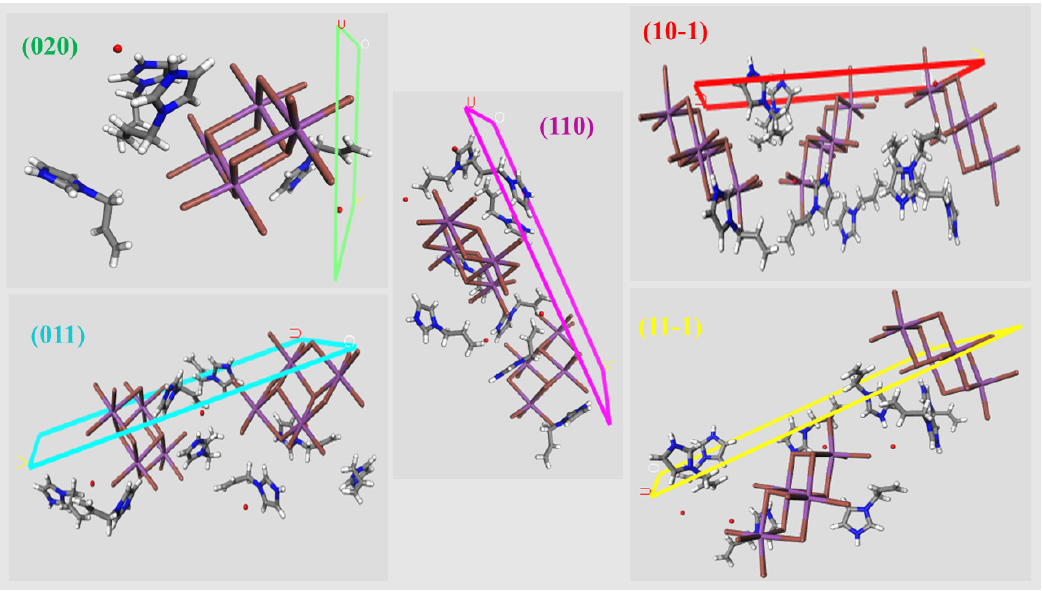
Figure 9. Cleavage structure of main exposure crystal planes of Bi 4 I 16 · 4(C 6 H 9 N 2 ) 2(H 2 O) indicating the presence of different functional groups.